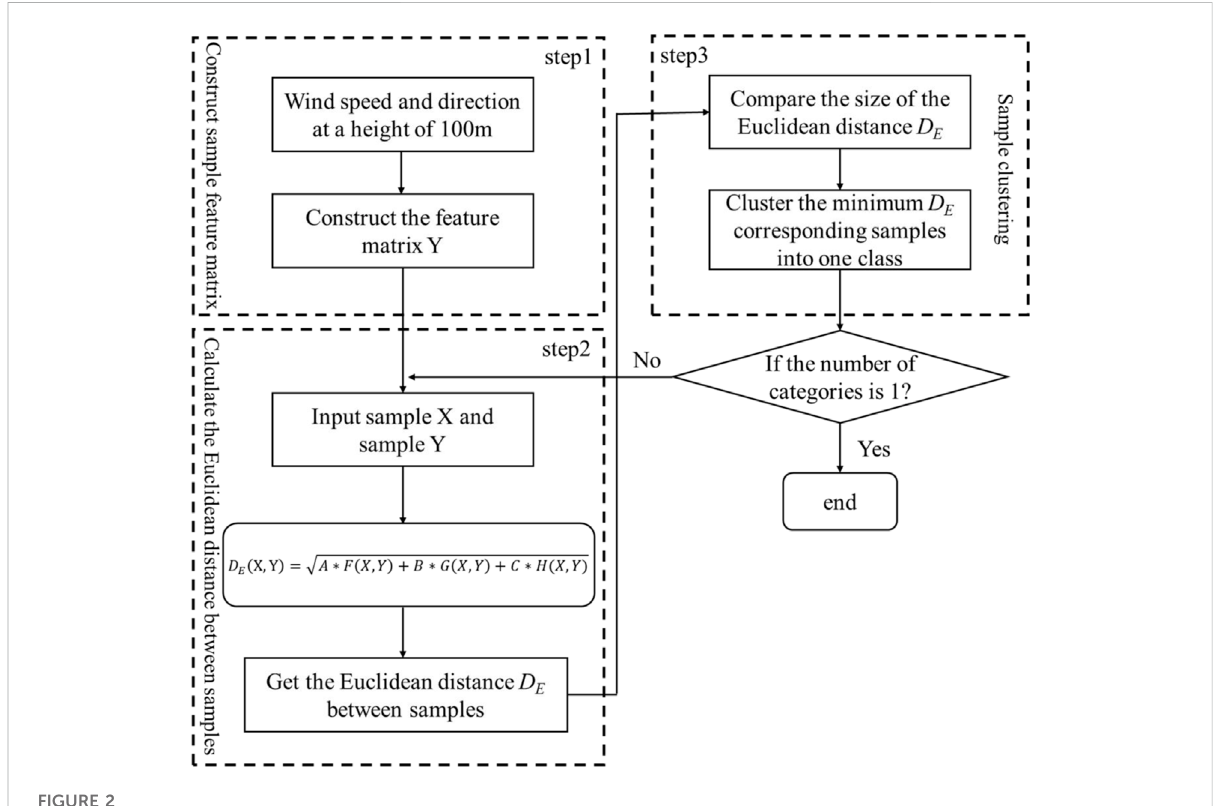
FIGURE 2 Flow chart of hierarchical clustering